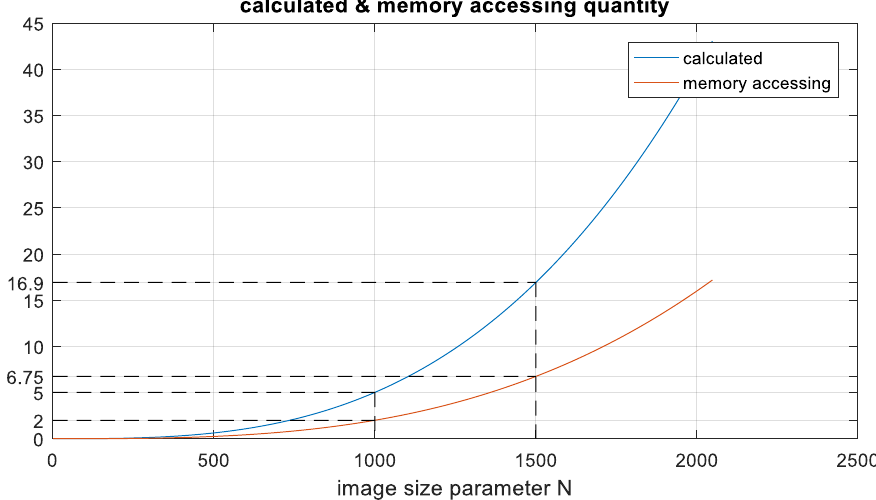
Figure 5. Plot of the quantity unit as a function of the image size parameter N for the calculated quantity and the number of memory reads and writes.